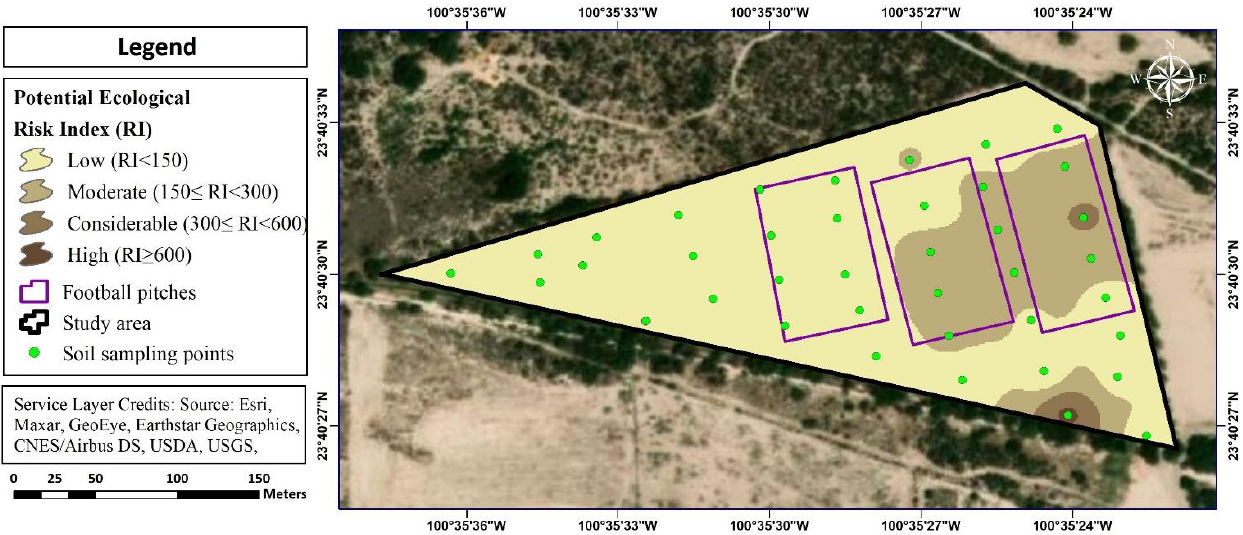
Figure 4. Spatial distribution of potential ecological risk index ( RI